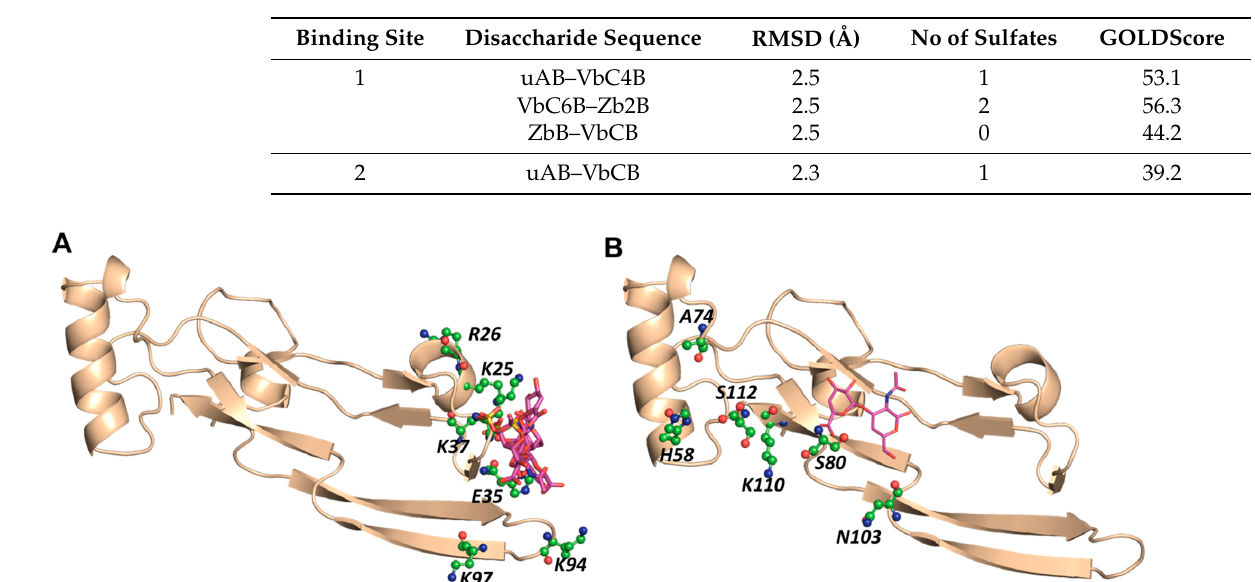
Table 1. CS disaccharide sequences from the library of the 24 sequences that satisfied the dual-filter